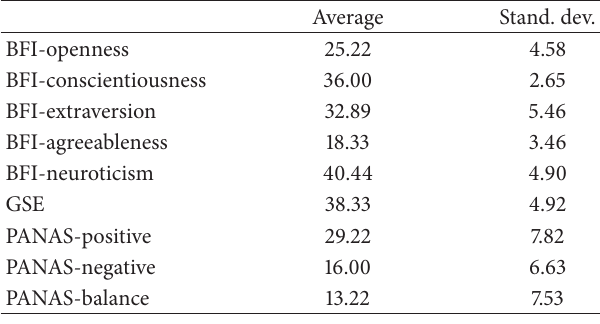
Table 1: Average and standard deviation for personality traits computed.